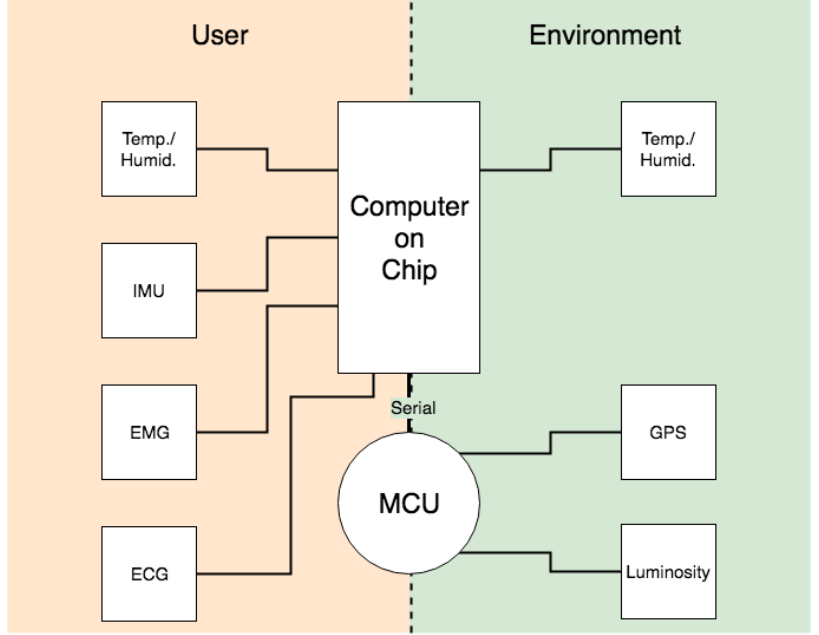
Figure 3. Proposed device